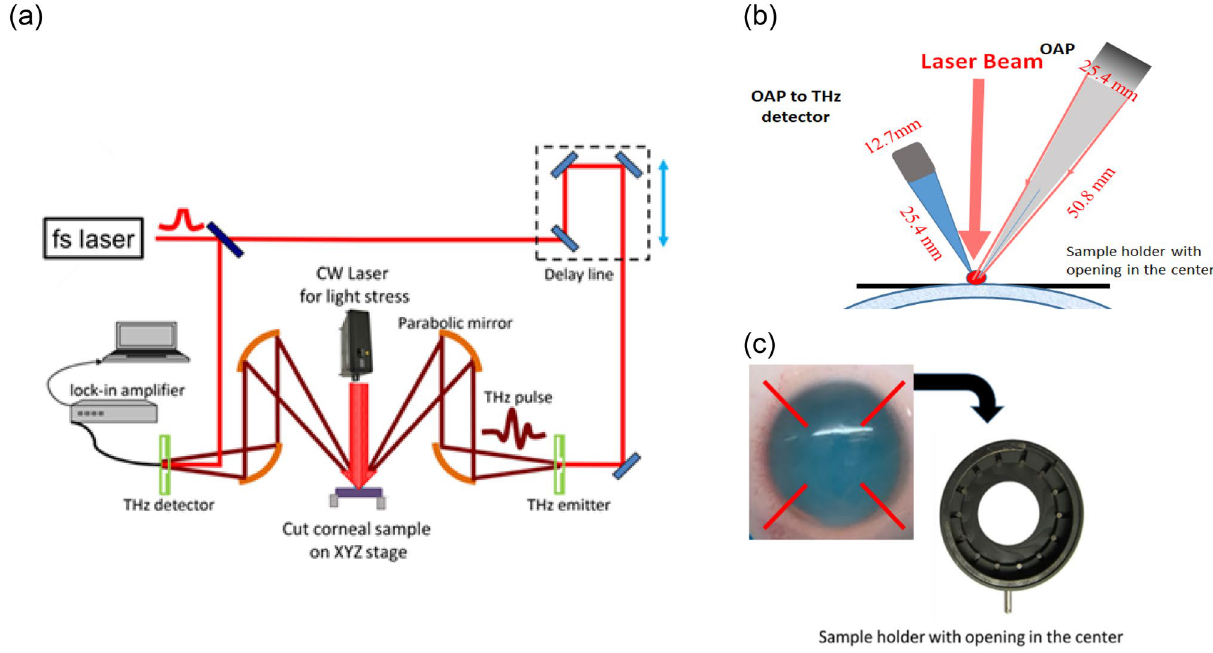
Figure 1. ( a ) Schematic THz spectroscopy measurement setup and light stress executed on top of the corneal sample. ( b ) Detailed information of parabolic focusing setup. ( c ) Sample has been flattened on holder with opening on the XYZ